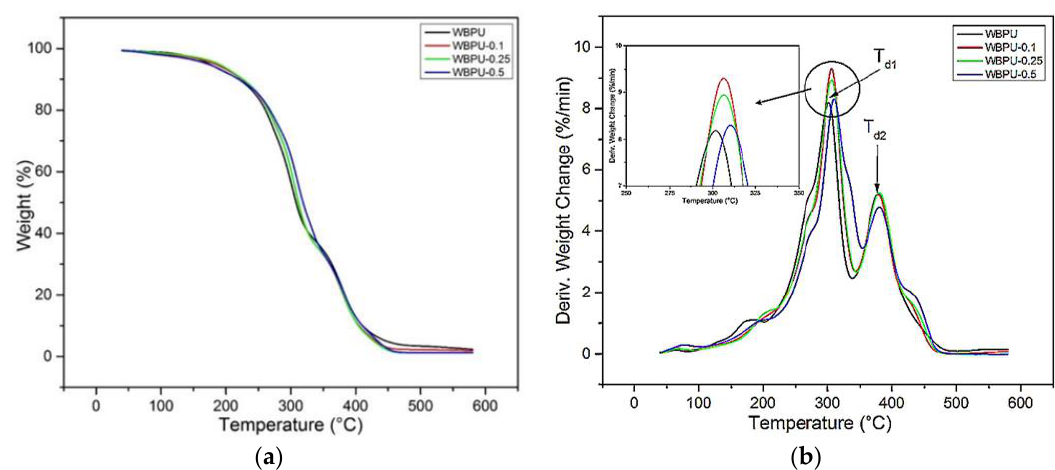
Figure 6. ( a ) TGA and ( b ) DTG curve for WBPU and WBPU-CNF nanocomposite films. Table 4. Thermal Properties of WBPU and WBPU-CNF nanocomposite